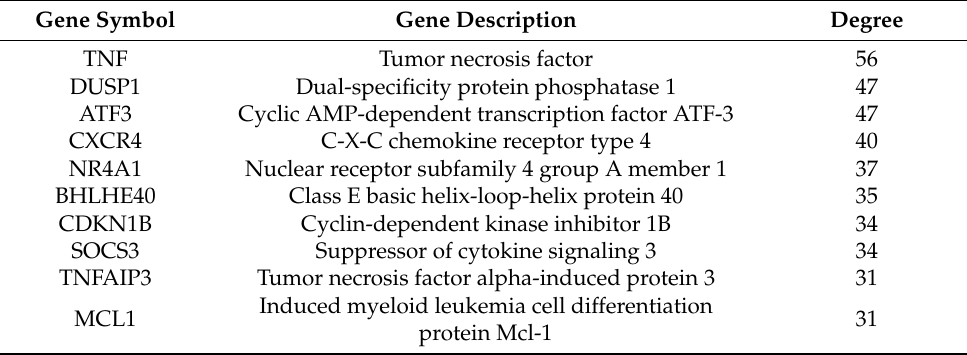
Figure 6. The top 10 hub genes screened by degree values. Different colors indicate the rank of degree. Table 3. Top 10 hub genes with higher degree of connectivity.